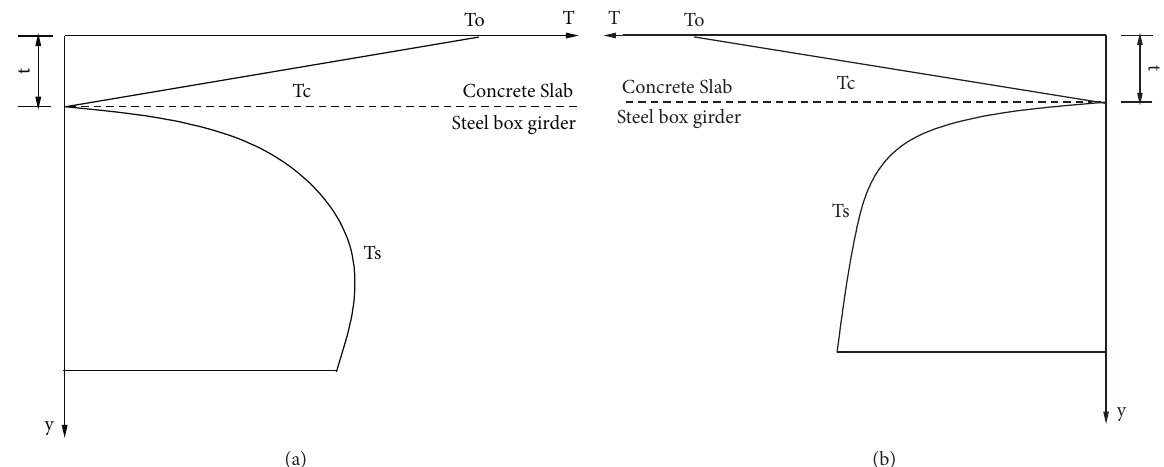
Figure 13: Most unfavourable curves of the temperature gradient on the vertical section. (a) Rise gradient after fitting. (b) Drop gradient after fitting.